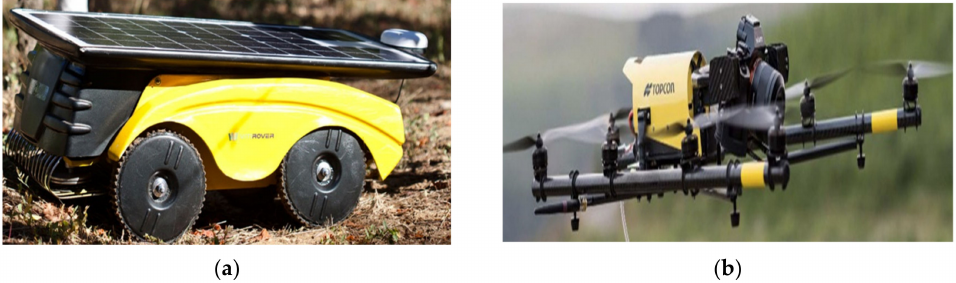
Figure 2. Image of solar-powered Vitirover robot in action on the ground ( a ); Falcon 8 drone employed to monitor, by means of the infrared (IR) sensors, the chlorophyll amount inside the vineyards ( b